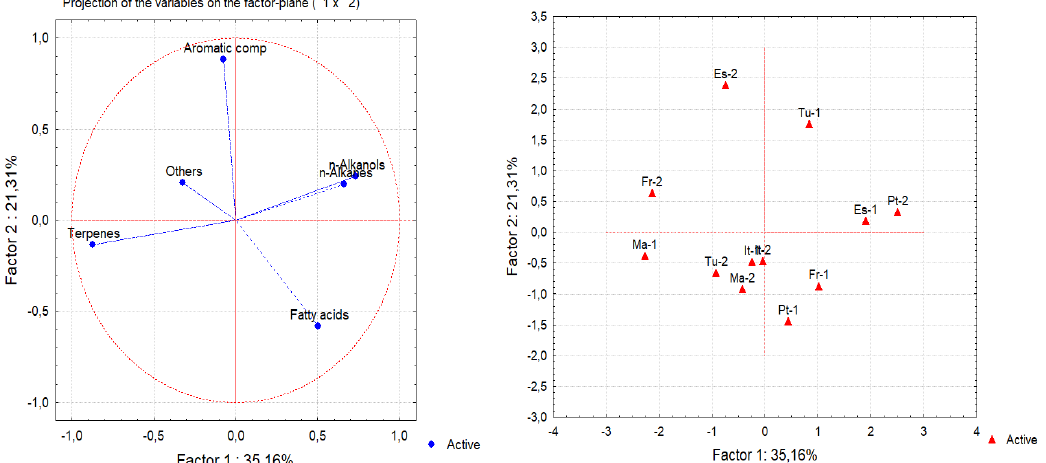
Figure 3. Principal component analysis (PCA) of the chemical classes of epicuticular wax compounds from leaves of 12 samples from six provenances: (left) score plots of the original variables; (right) sample plot (ES—Spain; Fr—France; IT—Italy; MA—Morocco; PT—Portugal; TU—Tunisia).